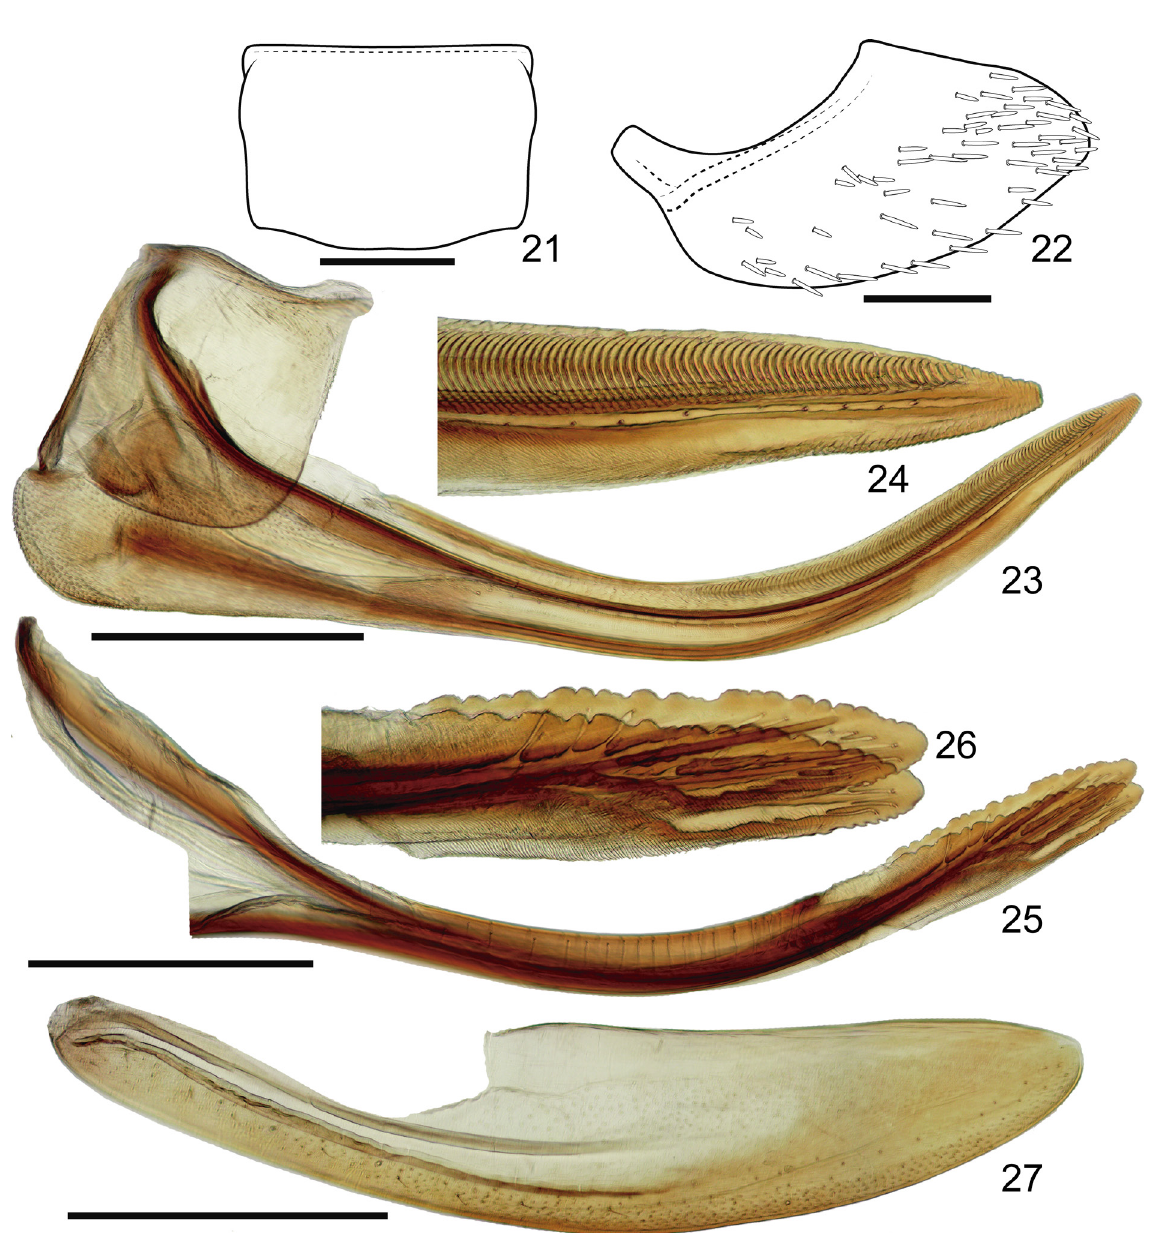
Figs 21–27. Guaricicana borgesi gen. et sp. nov., paratype, ♀ (DZUP 215378), terminalia. 21 . Sternite VII, ventral view. 22 . Pygofer, lateral view. 23 . First valvifer and first valvula, lateral view. 24 . Apex of first valvula, lateral view. 25 . Second valvula, lateral view. 26 . Apex of second valvula, lateral view. 27 . Gonoplac, lateral view. Scale bars = 0.5 mm; 24, 26 = not to